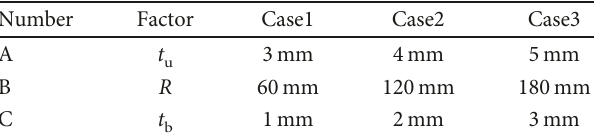
Table 2: Design of experiments with experimental conditions. Table 1: Levels of structural